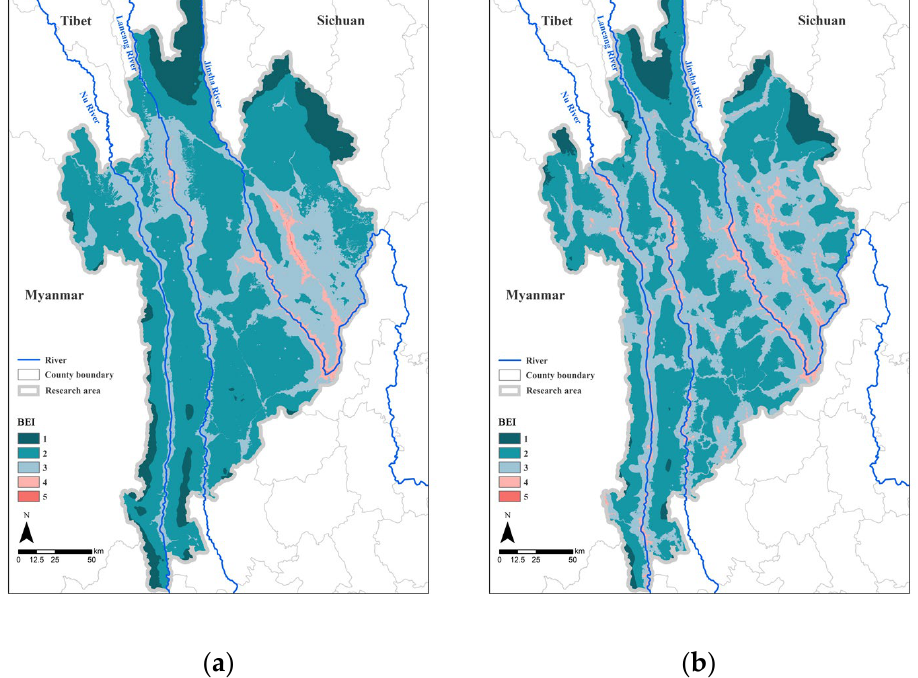
Figure 5. Map of the Three Parallel Rivers Natural World Heritage Site in 2000 ( a ) and 2020 ( b ) with BEI.